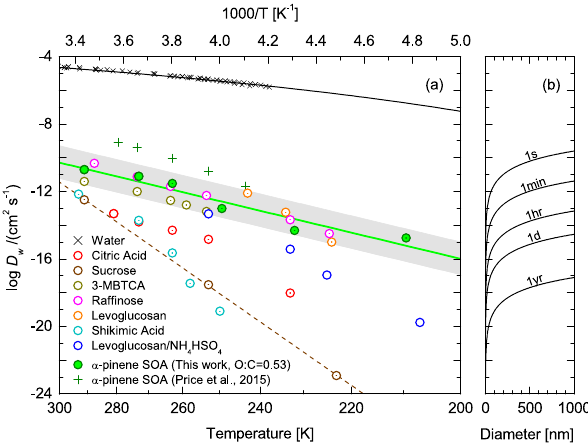
Figure 3. (a) Logarithm of the water diffusion coefficient in the pure component model mixtures, D w (T, 0 ) , from this and previ- ous work (Zobrist et al., 2011; Lienhard et al., 2014; Steimer et al., 2015), displayed as a function of temperature (bottom scale) and inverse temperature (top scale). The green solid line and the brown dashed line are the parameterizations of α -pinene SOA and sucrose, respectively. The light-gray shaded area marks a range of water dif- fusivity in the SOA extract ± 1 order of magnitude. The solid black line represents the self-diffusion coefficient of water, D w (T, 1 ) , ac- cording to Smith and Kay (1999) with measurements indicated by black crosses (Pruppacher, 1972; Gillen et al., 1972; Price et al., 1999). Circles with a centered dot indicate that the data point is below the glass transition temperature. Water diffusivities in an α - pinene SOM of unknown O:C ratio reported recently by Price et al. (2015) are shown for comparison. (b) Upper limits of equilibration times for particles of different sizes calculated by assuming that the diffusivity follows Fick’s law according to Eq.